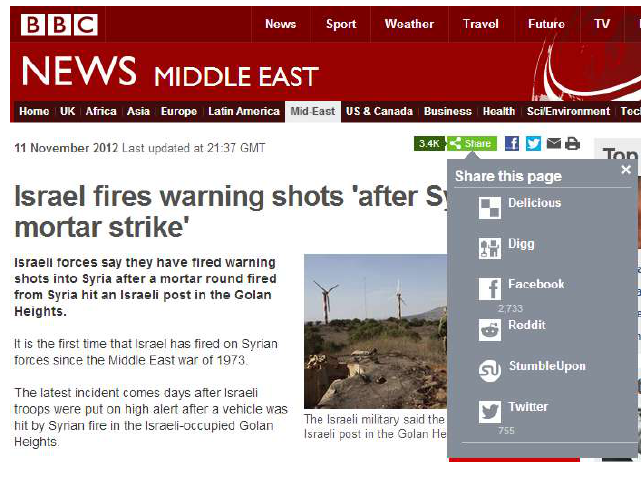
Figure 7: BBC News Story